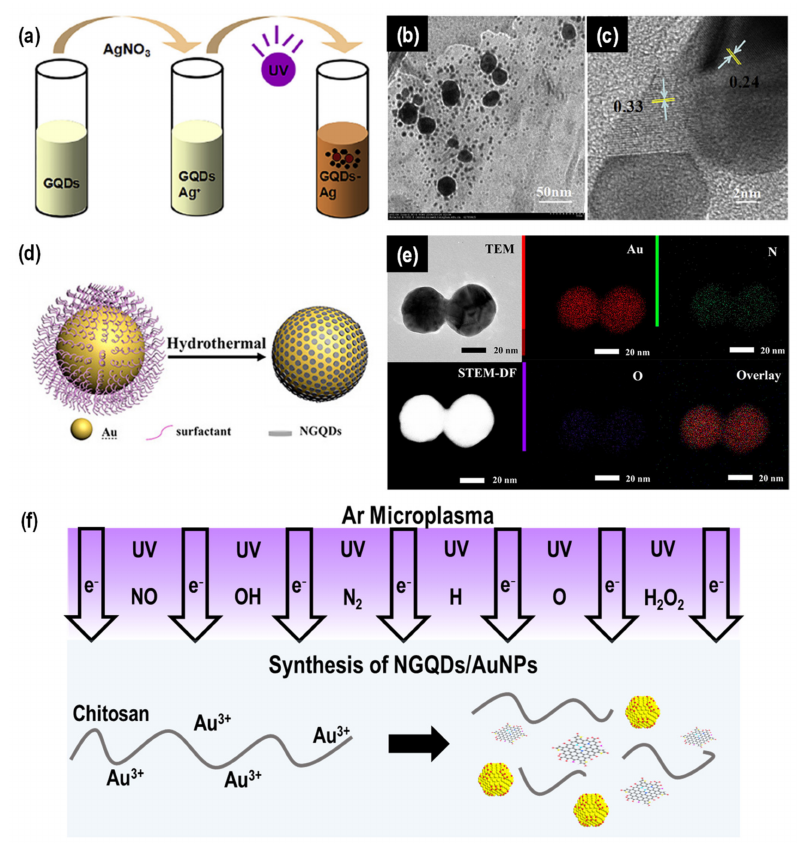
Figure 7. In situ preparation of GQD-inorganic nanocomposites. ( a ) Schematic illustration of the synthesis of Ag-GQD nanocomposites [83]. ( b ) TEM and ( c ) HRTEM images of Ag-GQDs [83]. ( d ) Schematic illustration of the synthesis of Au-NGQD nanocomposites [85]. ( e ) TEM, STEM- HAADF, Au, N, O and overlay elemental mapping of Au-NGQDs [85]. ( f ) Schematic illustration